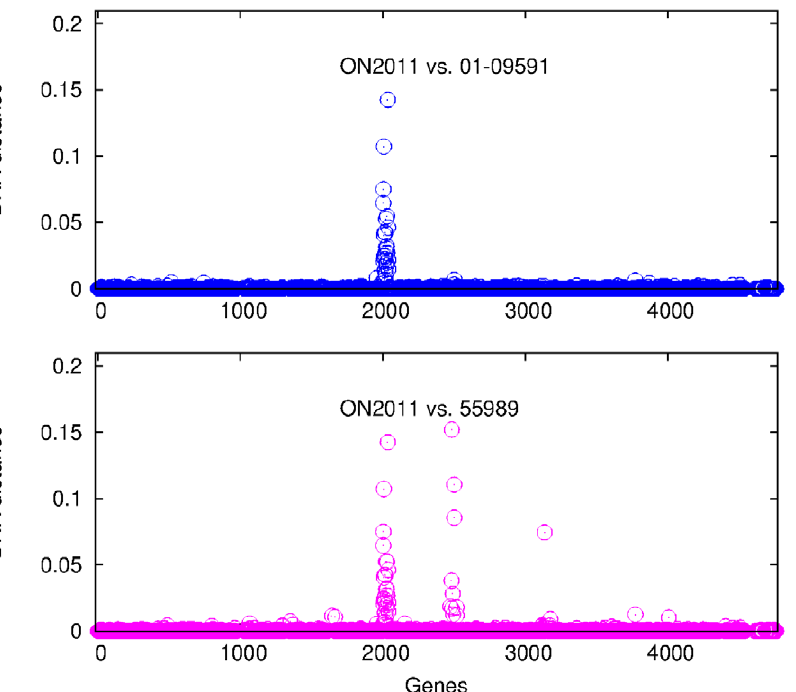
Figure 11. DNA distance between ON2011 vs. 55989 and between ON2011 and 01-09591. The data are plotted as of the gene order on the 55989 chromosome.